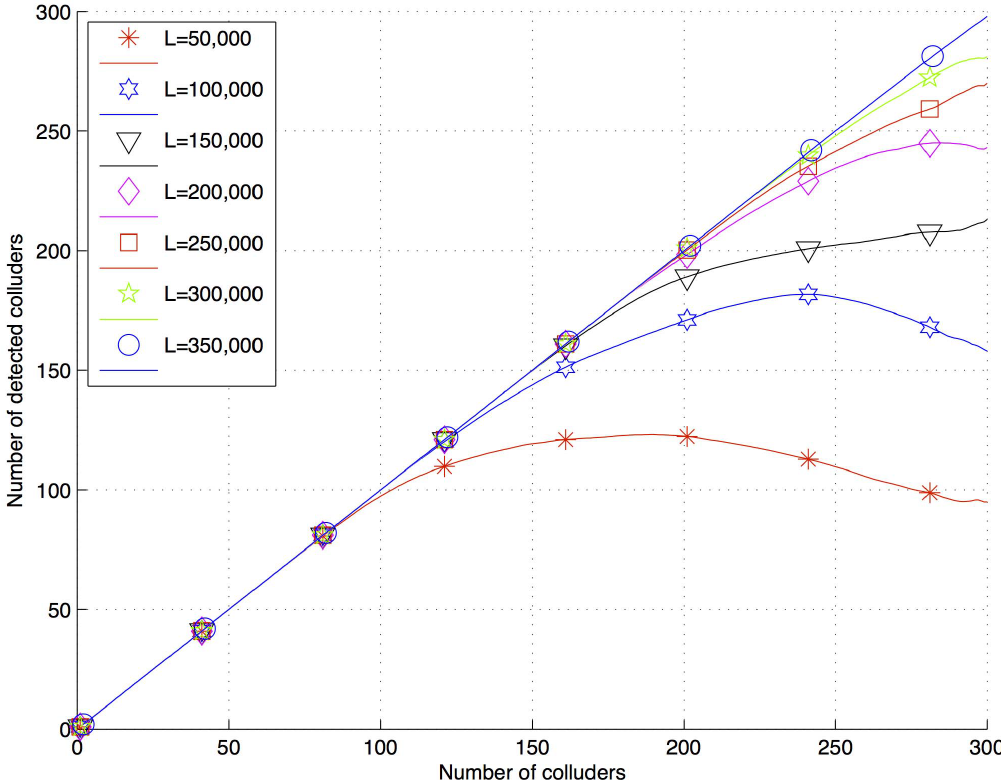
Figure 7. Number of detected colluders after a collusion attack for fingerprints generated with B g ~ 50,000, B u ~ 200,000 and P w ~ 1 = 6 .